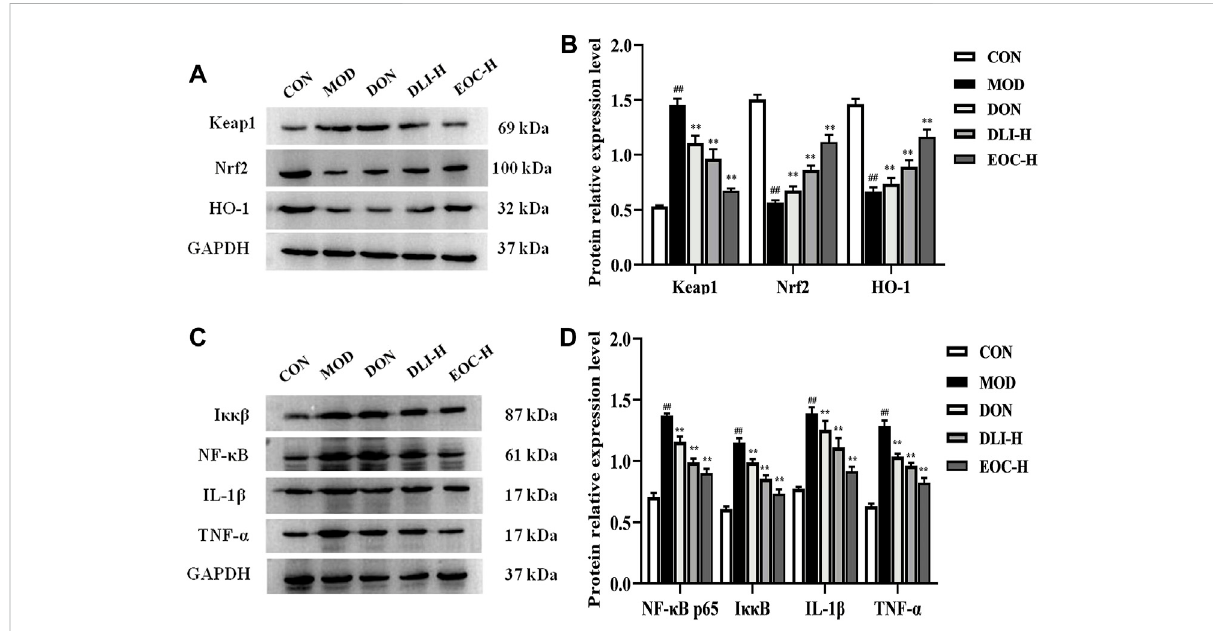
FIGURE 7 Effect of EOC in the hippocampus via Nrf2/ NF- κ B ( n = 5). (A,C) Western blot images. (B,D) Relative expression of the protein. # p < 0.05; ## p < 0.01 vs. the CON group; * p < 0.05, ** p < 0.01 vs. the MOD